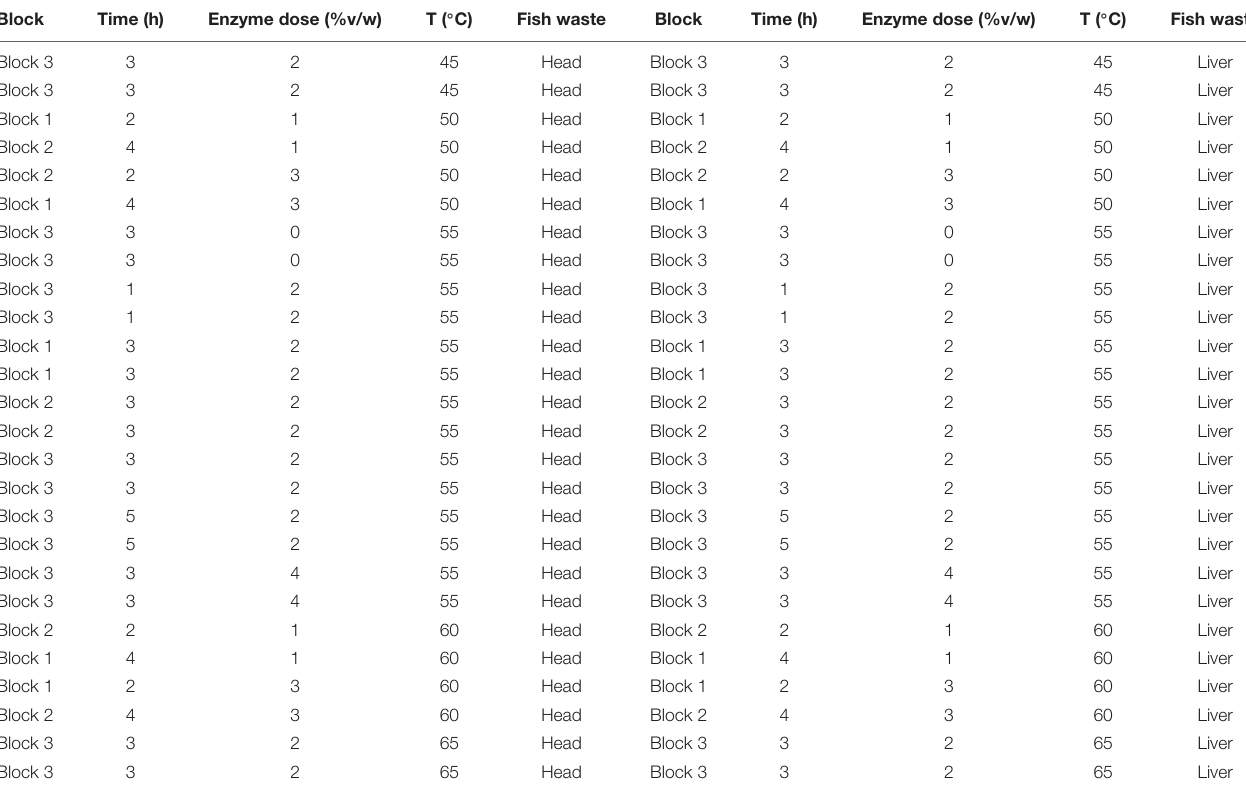
TABLE 1 | Central composite design of fish waste